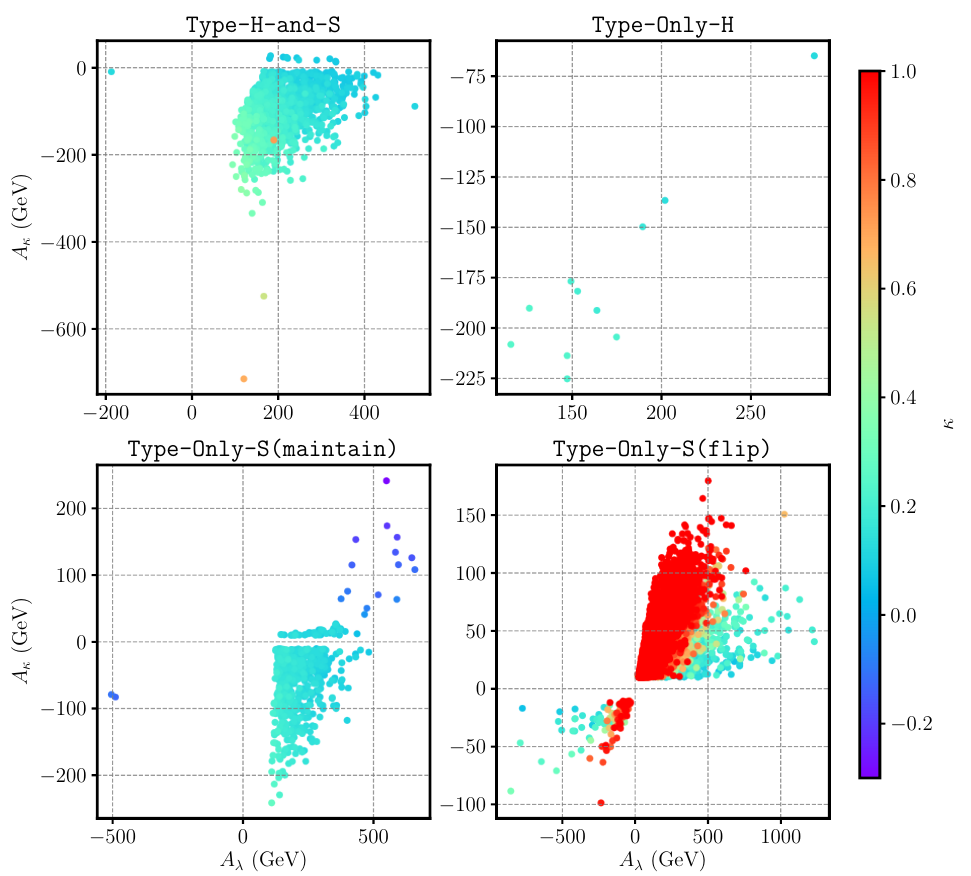
Figure 6 . The trilinears ( A (cid:21) ; A (cid:20) ) for samples for which the strongest FOPT ends in the SM vacuum. The points are colored by the parameter (cid:20)